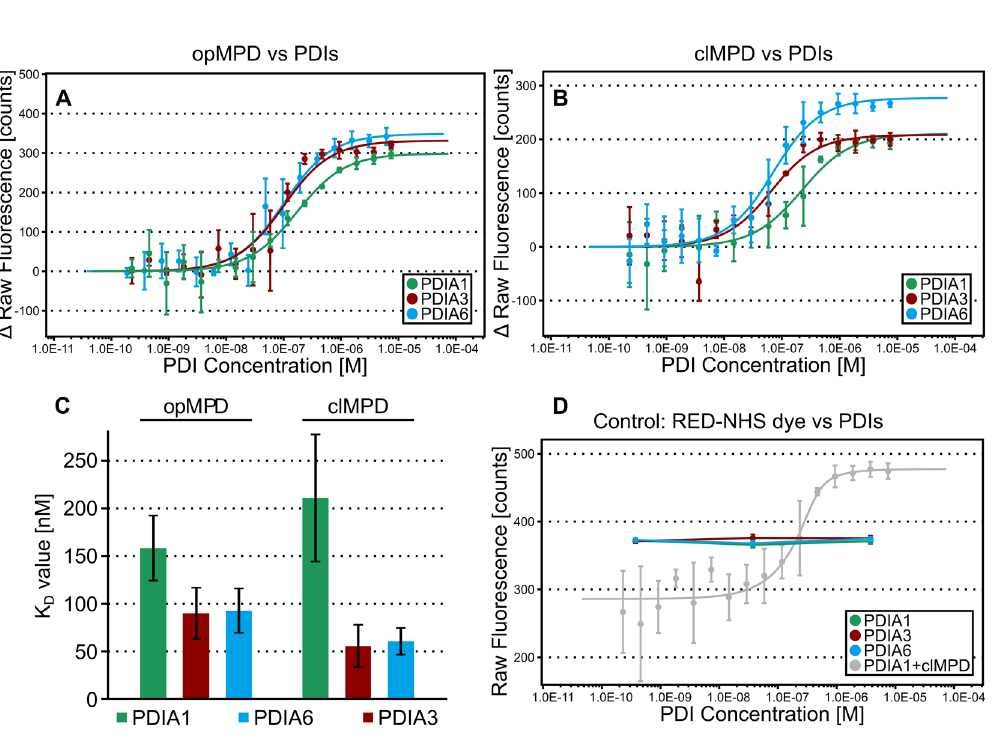
Figure 3. MST analysis of PDIs and MPD. (A and B) Dose-response curves of MST analysis (initial fluorescence, n = 3) of PDIA1, PDIA3 and PDIA6 with opMPD ( A ) or clMPD ( B ) as indicated in the caption. ( C ) Summary of the K D values shown as column chart (error bars indicate respective 68% confidence intervals). The evident differences of the K D values are not significant (95% confidence intervals overlap, not shown for clarity). ( D ) The dose-response curves of the initial fluorescence intensity of the control experiment to test for unspecific binding of PDIA1, PDIA3 and PDIA6 to the RED-NHS dye (3 concentrations, each n = 3, curve of PDIA1 against clMPD for reference in grey) show no PDI-concentration-dependent shift of the initial